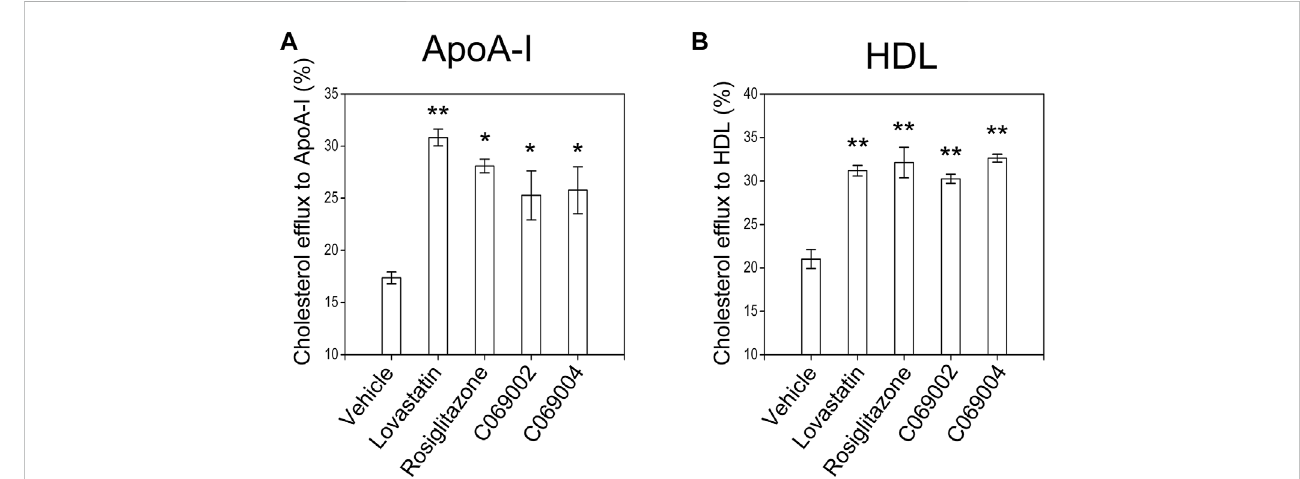
FIGURE 4 Diterpenoids promote cholesterol ef fl ux in RAW264.7 macrophages. RAW264.7 macrophages were preincubated with 22-NBD-cholesterol for 24 h, after which the cells were washed with PBS and incubated with the indicated drugs and chemical compounds (15 μ mol/L). After 18 h, (A) 10 μ g/mL ApoA-I or (B) 50 μ g/mL HDL was added, and theincubation continued for 6 h at37 ° C.The amounts of cholesterolin the medium and cells were measured. The relative 22-NBD-cholesterol ef fl ux to ApoA-I or HDL induced by the diterpenoids was calculated. Similar results were obtained in three